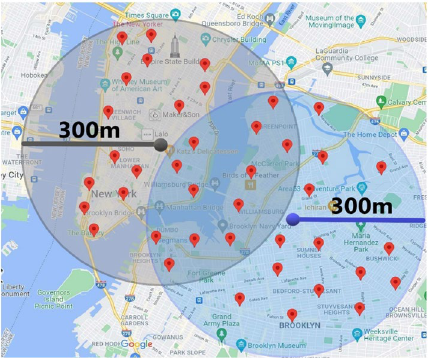
Figure 1. Location perturbation will lose LBS services outside the intersection area. Geo-information obtained via Google Maps (https:// www. google. com/ maps, Latitude: 40.7185036, Longitude: − 73.9648126, Elevation: 13.02) and the user’s quering range and POI have been marked